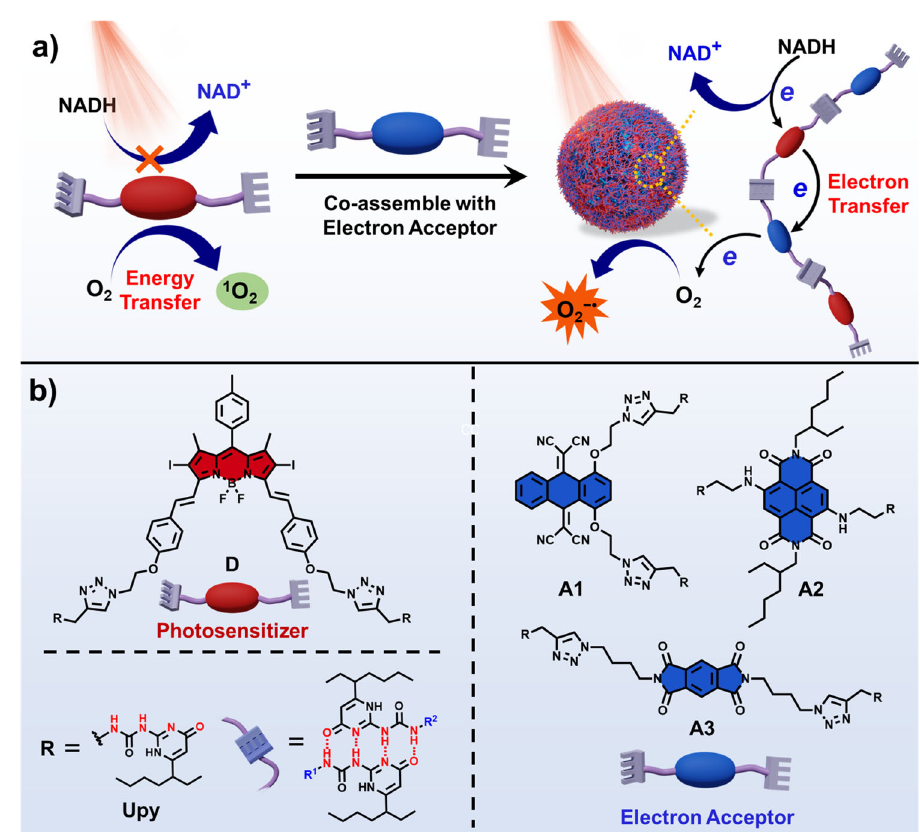
Fig. 2 | Schematic representation of PDT based on supramolecular photo- dynamicagents.a Schematicillustrationofthepreparationofthesupramolecular photodynamic agent, as well as photo-induced oxidation of NADH and